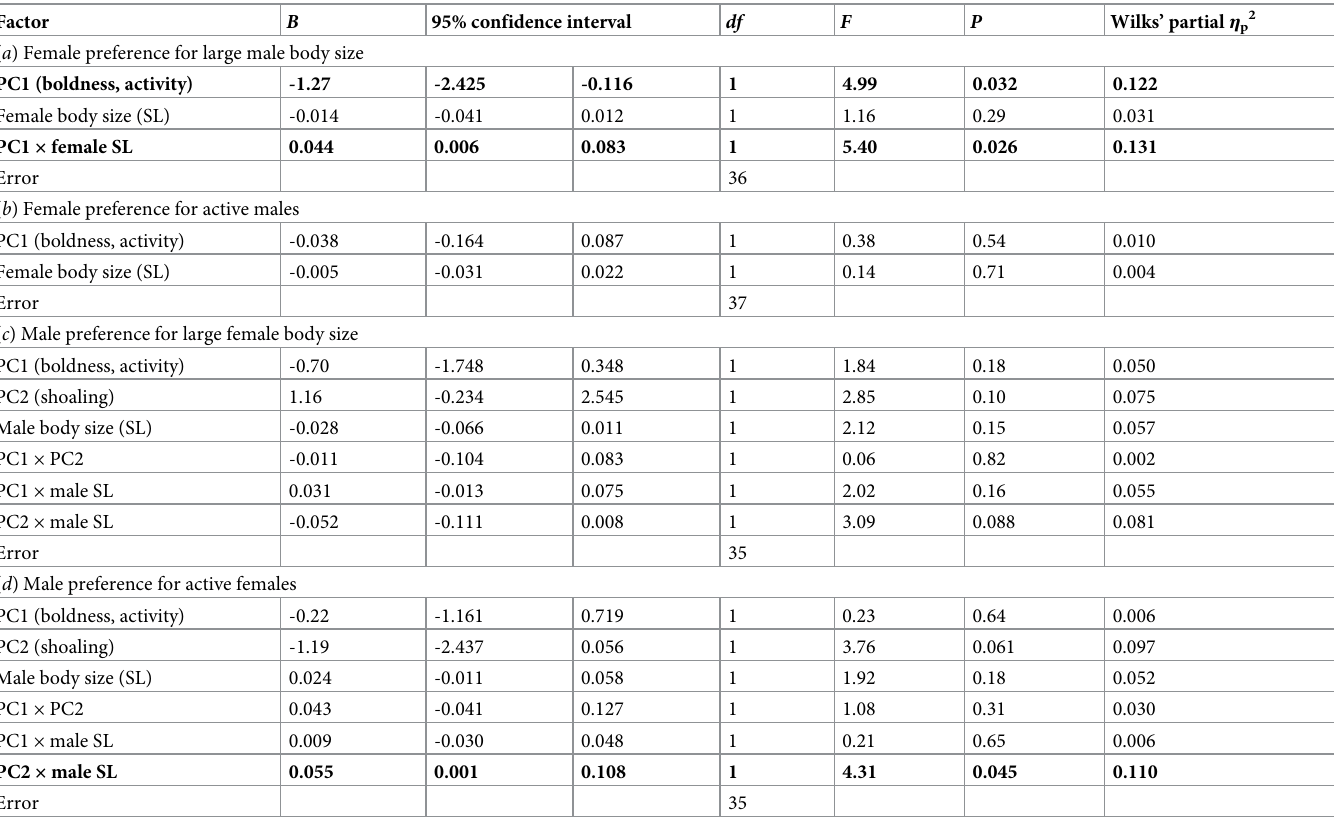
Table 2. Results of General Linear Models (GLMs) testing for the effects of the choosing individual’s personality type (PCs; Table 2) and body size (SL) of the choos- ing individual on the strength of female ( a , b ) and male preferences ( c , d ). Factor B 95% confidence interval df F P Wilks’ partial η